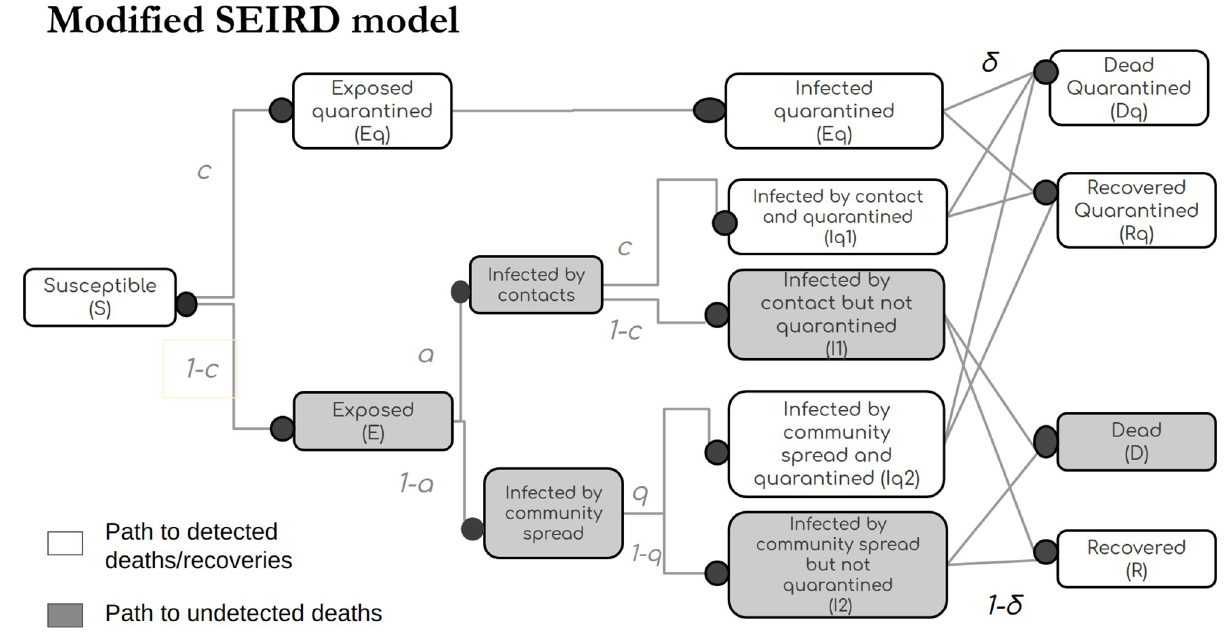
Fig 1. Figure adapted from [14] describes the fraction of population flowing through each compartment in the parallel arms of the modified SEIRD model.